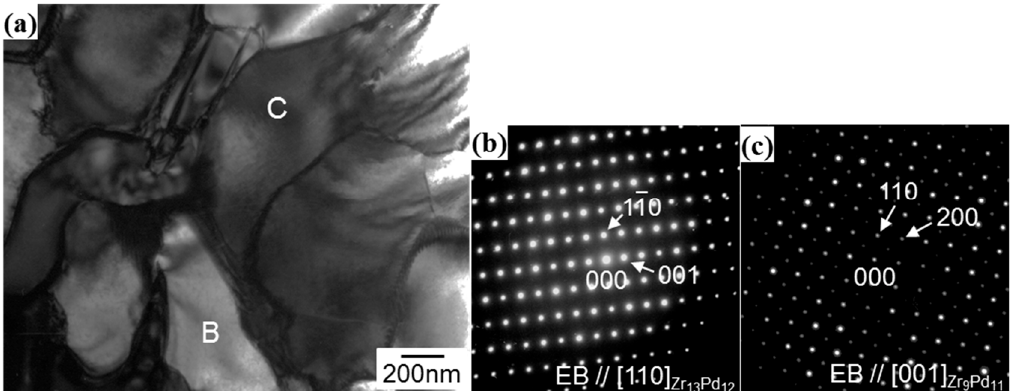
Figure 7. ( a ) Bright field image of the Zr-51 atom % Pd alloy aged at 973 K for 720 ks. ( b , c ) Electron diffraction patterns are taken from the areas marked B and C in ( a ), respectively. The patterns shown in ( b , c ) are indexed according to the Zr 13 Pd 12 and Zr 9 Pd 11 compounds, respectively. In order to determine the eutectoid temperature, diffusion couple experiments have been carried